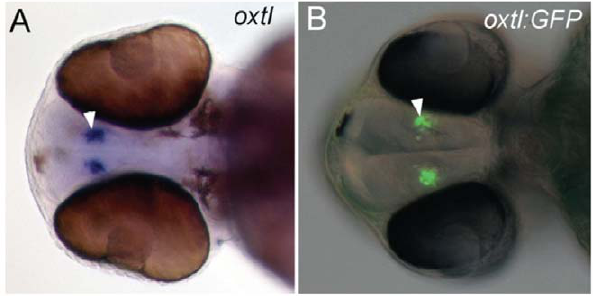
Figure 6. Expression of GFP in Tg(oxtl:GFP) embryos corre- sponds exactly with the expression of endogenous oxtl mRNA. A,B , ventral view of 48 hpf embryos. A , whole-mount in situ hybridization for oxtl mRNA in a 48 hpf embryo. B , GFP expression visualized with epi-fluorescence in a 48 hpf Tg(oxtl:GFP) embryo. Epi- fluorescent and differential interference contrast (DIC) images are overlaid. The oxtl expressing cells are indicated with arrowheads.